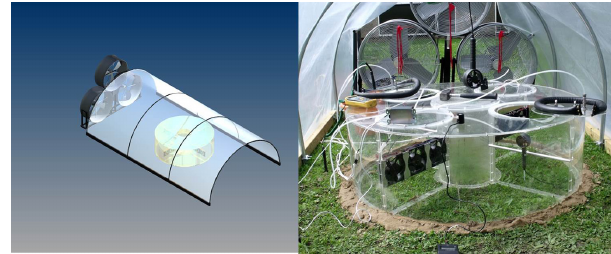
Figure 1. The nested wind tunnel system. Note high-speed fans within the toroid at east and west compass points, with anemome- ters measuring wind speeds at points north and south. Toroid vents are open at this point and all internal fans are off. Wind tunnel sides are PAR transparent in this picture and drum fans at the end of the agricultural tunnel are off. Pressure differential gauges can be seen above fan banks and the PAR sensor is front and centre on the top of the flux